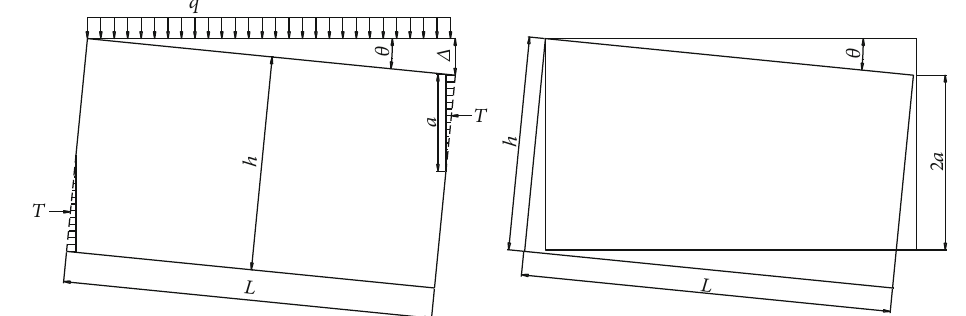
Figure 4: Equivalent model of layered strata in the period of fi rst